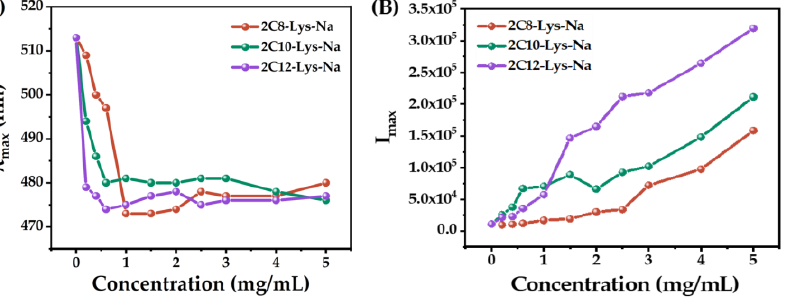
Figure 5. Dependence of ( A ): luminescence maxima ( λ max ) and ( B ): maximum luminescence intensi- ties ( I max ) on the concentration of 2C8-Lys-Na, 2C10-Lys-Na, and